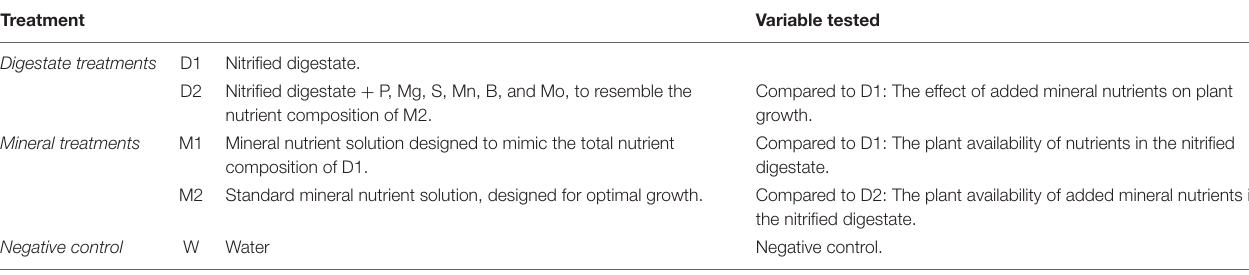
TABLE 1 | Fertilizer treatments in the soilless production of pak choi and the main variables tested. Treatment Variable tested Digestate treatments D1 Nitrified